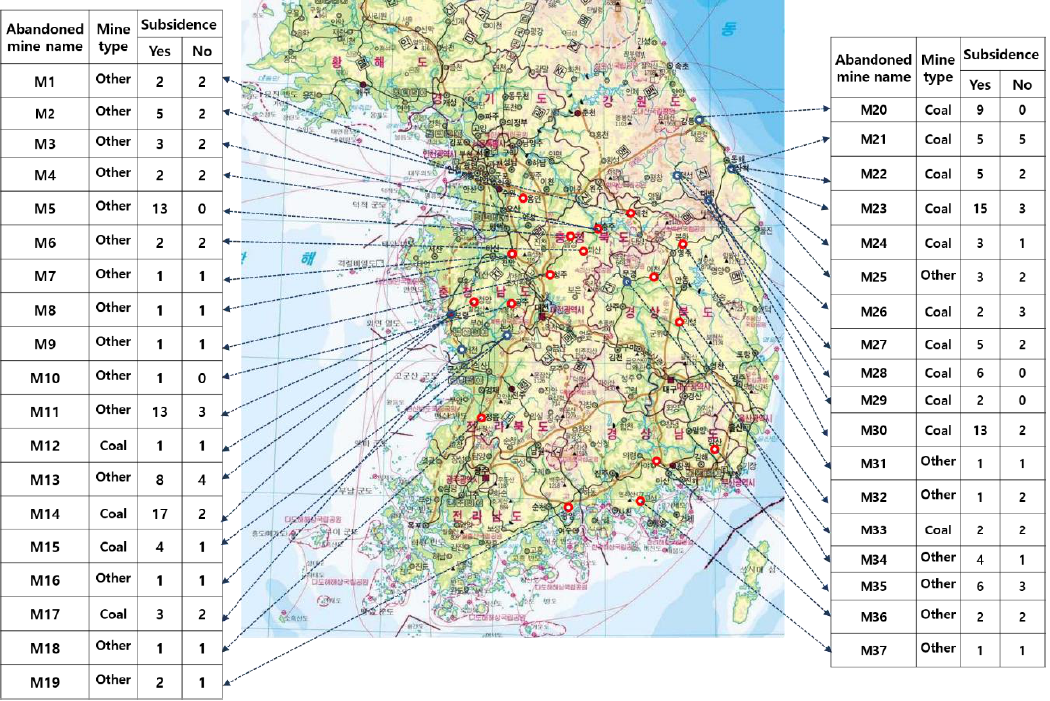
Figure 5. Locations of selected and investigated abandoned mines.